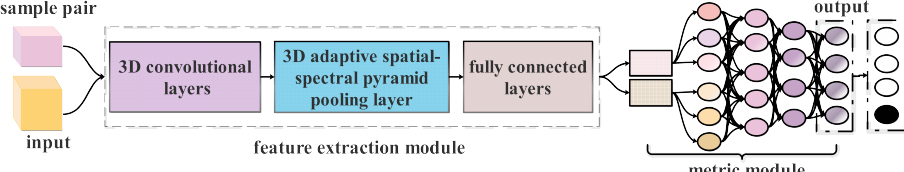
Figure 4. Architecture of a developed Siamese CNN with adaptive spatial-spectral pyramid